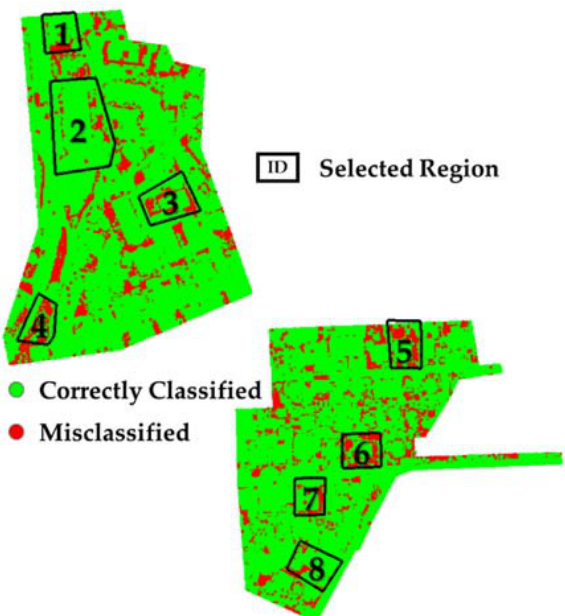
Figure 9. Selection of typical error regions from the prediction of the prior-level fusion strategy.